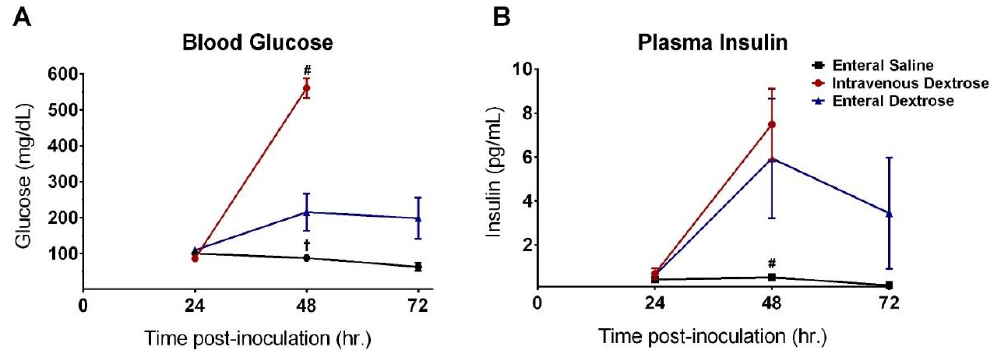
Figure 6. Enteral dextrose infusion promotes euglycemia in septic mice. ( A ) Blood glucose measured at 24 h intervals post-inoculation. ( B ) Plasma insulin measured at 24 h intervals post-inoculation. Two-way ANOVA was used to compare groups at all timepoints with Tukey’s multiple-comparison test. # = IV dextrose compared to enteral dextrose at 48 hpi, p < 0.01. † = Enteral saline compared to enteral dextrose at 48 hpi, p = 0.015.